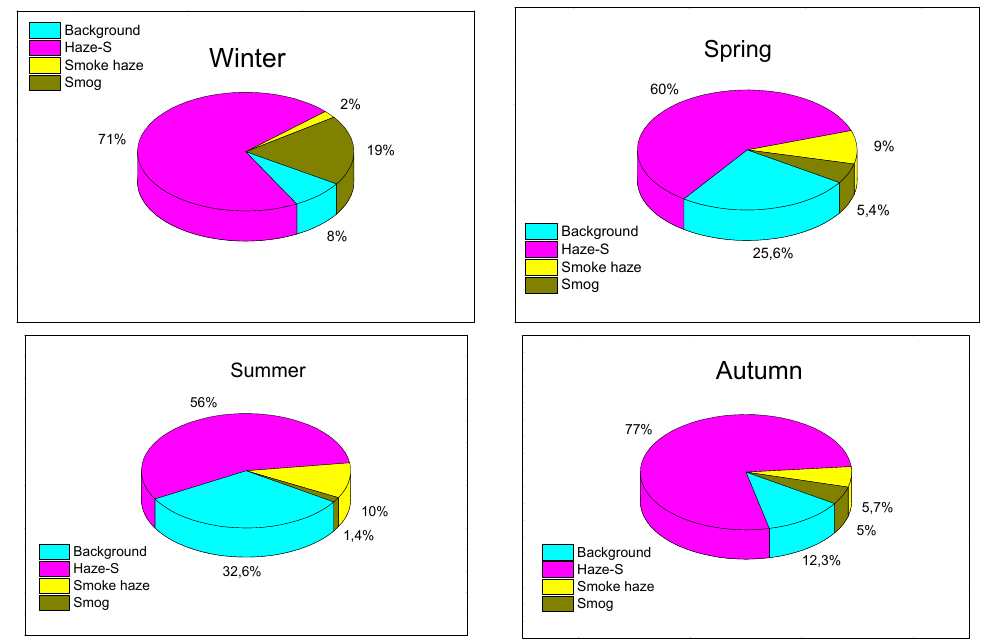
Figure 1. Percentage of occurrences of aerosol weather types in different seasons according to the data set obtained in 2000–2017.